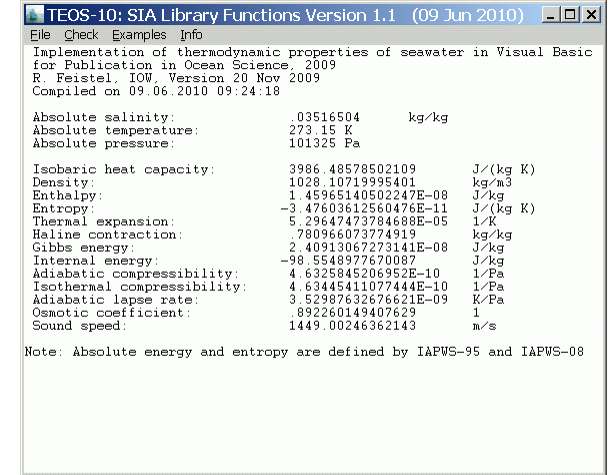
Fig. 4.4: List of selected SIA seawater properties available from the menu “Examples” Fig. 5. List of selected SIA seawater properties available from the menu